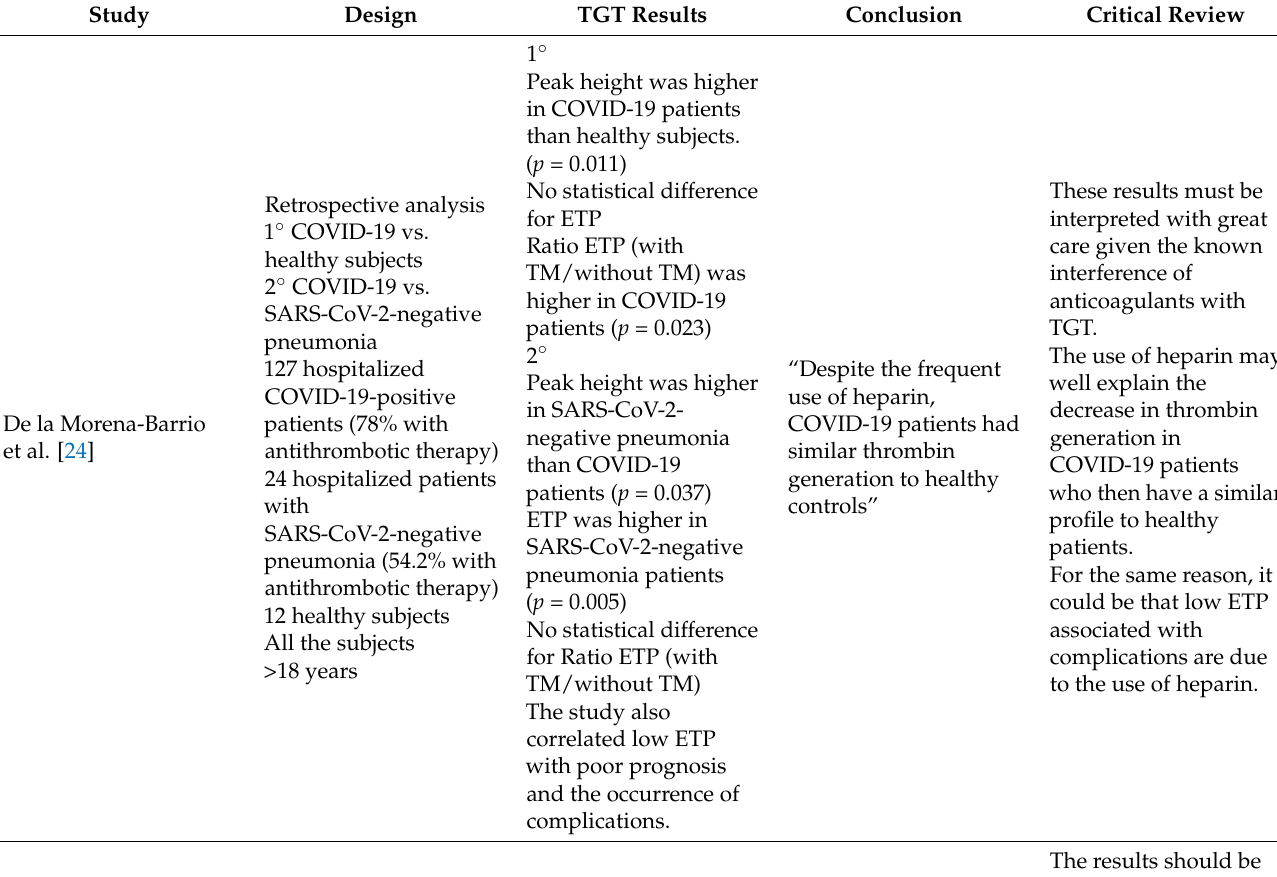
Table 3. Comparison of various studies that treated TGT in COVID-19